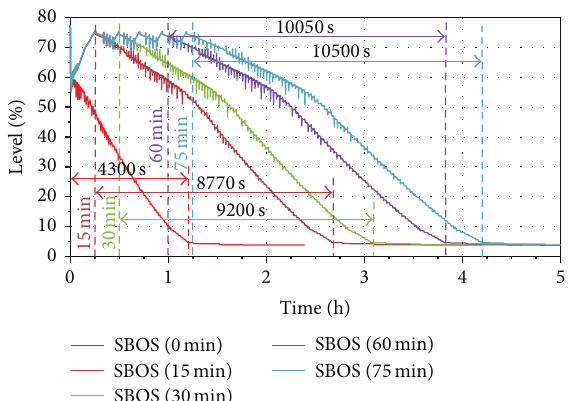
Figure 4: SG number 1 wide range level, SBOS case scenarios.